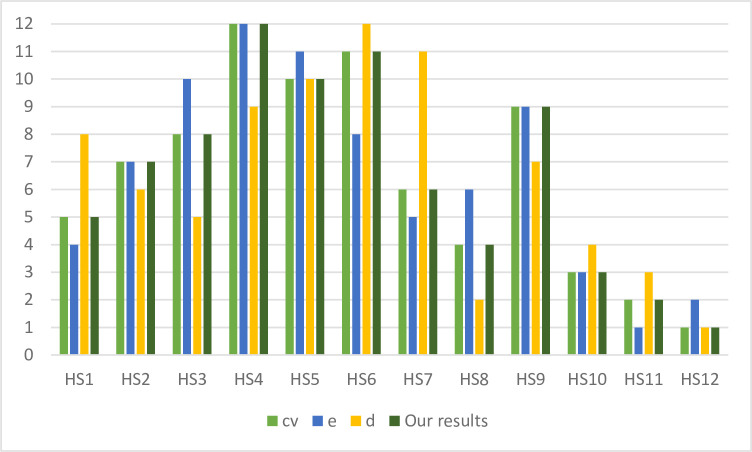
Ranking comparison.